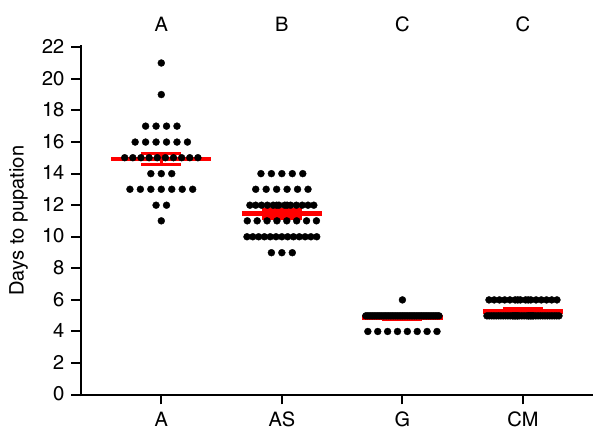
Fig. 3 Delayed development in axenic larvae. Time to pupation is shown for axenic (A), axenic supplemented with heat-killed E. coli (AS), gnotobiotic (G), and colony microbiome (CM) larvae. Points represent time to pupation for individual larvae. The experiment was performed with 18 individuals per treatment (three six-well plates), with three independent replications (i.e., 54 individuals). The central red line denotes the mean pupation time, with the bars indicating the standard error of the mean. Statistically signi fi cant differences between groups were identi fi ed with the Kruskall – Wallis test and columns labeled with different letters were signi fi cantly different with a P -value <